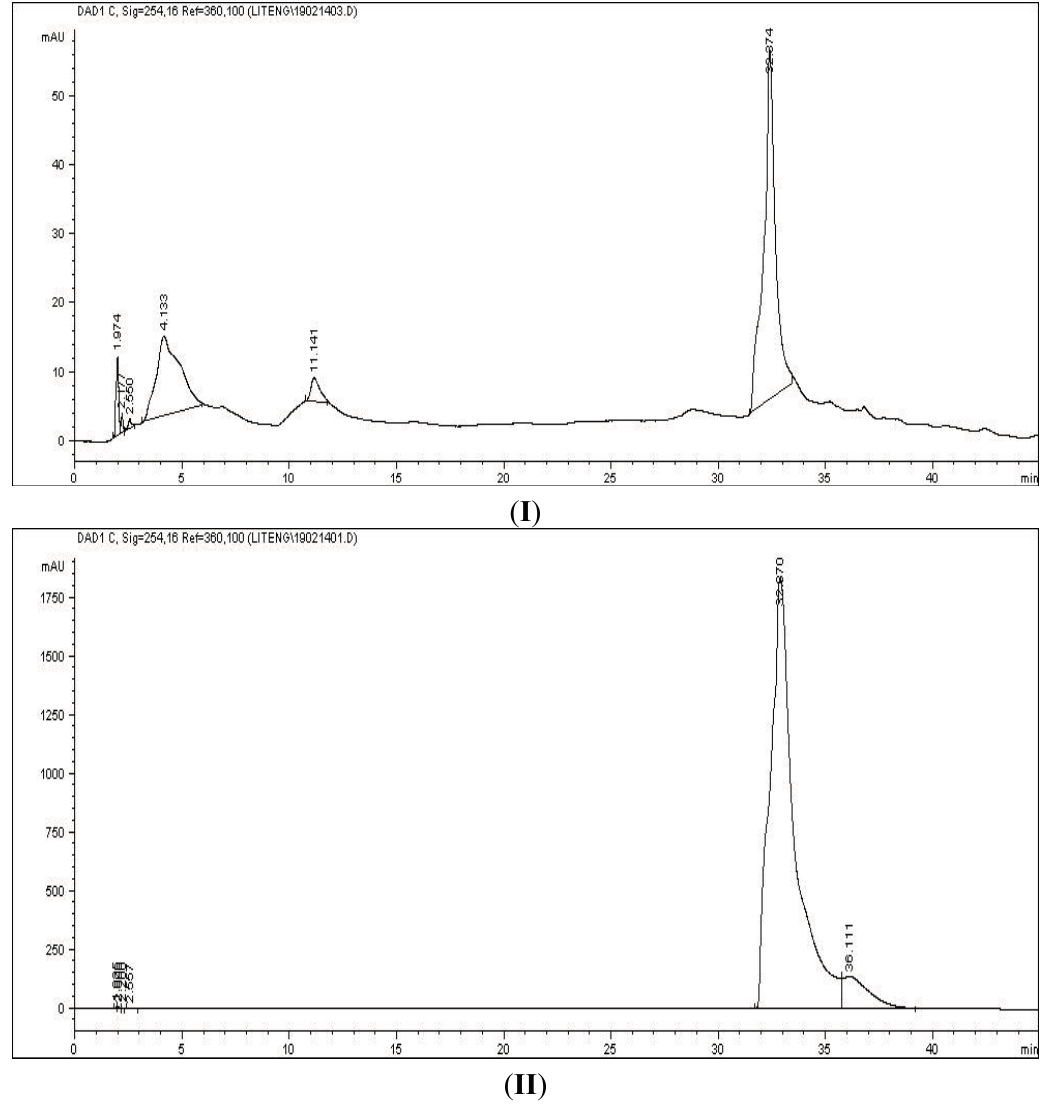
Figure 4. HPLC chromatograms of Subfraction B ( I ) and cinnamic acid ( II ) using a C-18 Hypersil Gold column, with water ( A )/methanol ( B ) as mobile phase. Sample was separated under gradient elution condition at flow rate 1 mL/min. The wavelength was 254